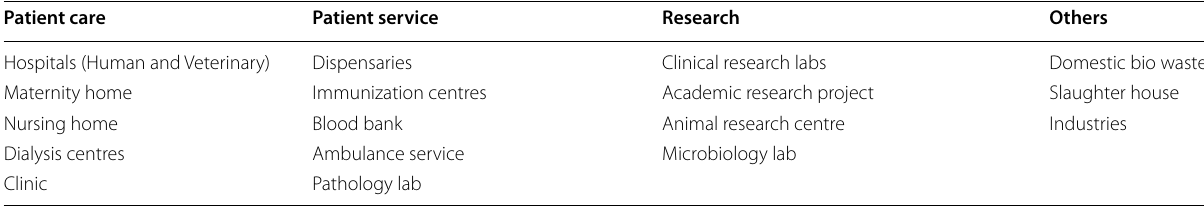
Table 1 Sources of generation of biomedical waste